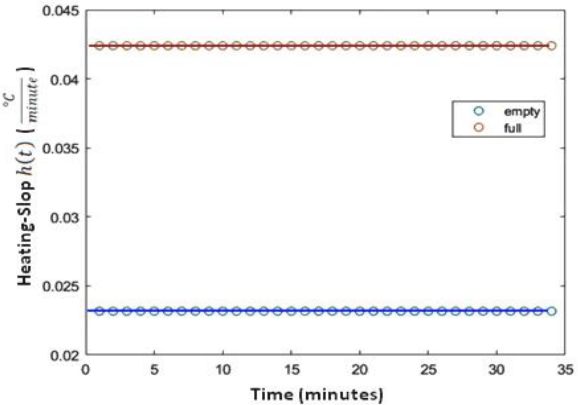
Figure 9. Heating slop when the living space is empty and when it is fully occupied.